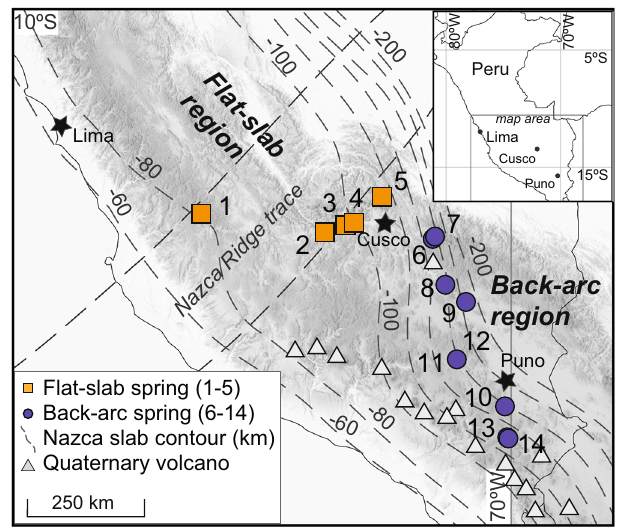
Fig. 1 Location of the 14 investigated hot springs in the fl at-slab and back-arc regions of Peru. Subducting Nazca slab contours after Hayes et al. 47 . Note the slab steepening southeast of the subducting Nazca ridge trace and the appearance of active arc